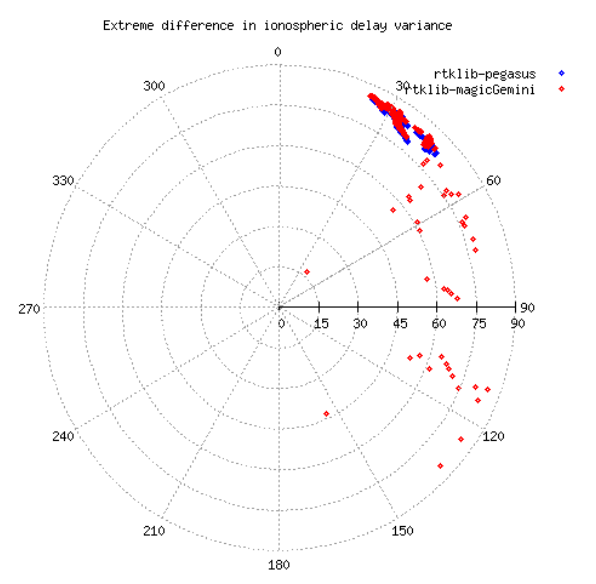
Figure 5. Extreme large differences of ionospheric delay